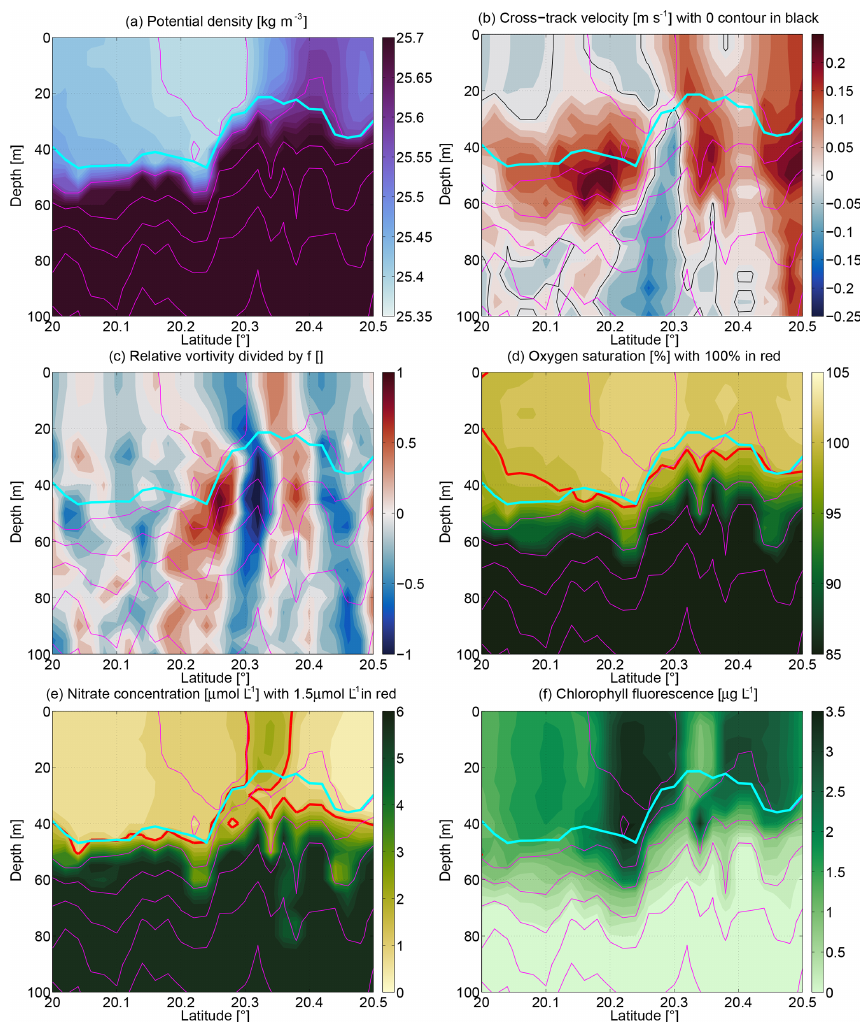
Figure 10. Sections zoomed in on the upper 100m over 55km in the south of the transect. (a) Potential density (in kilograms per cubic meter), (b) cross-track velocity (in meters per second), (c) relative vorticity divided by f , (d) oxygen saturation (in percent), (e) nitrate concentration (in micromoles per liter), and (f) chlorophyll- a fluorescence (in micrograms per